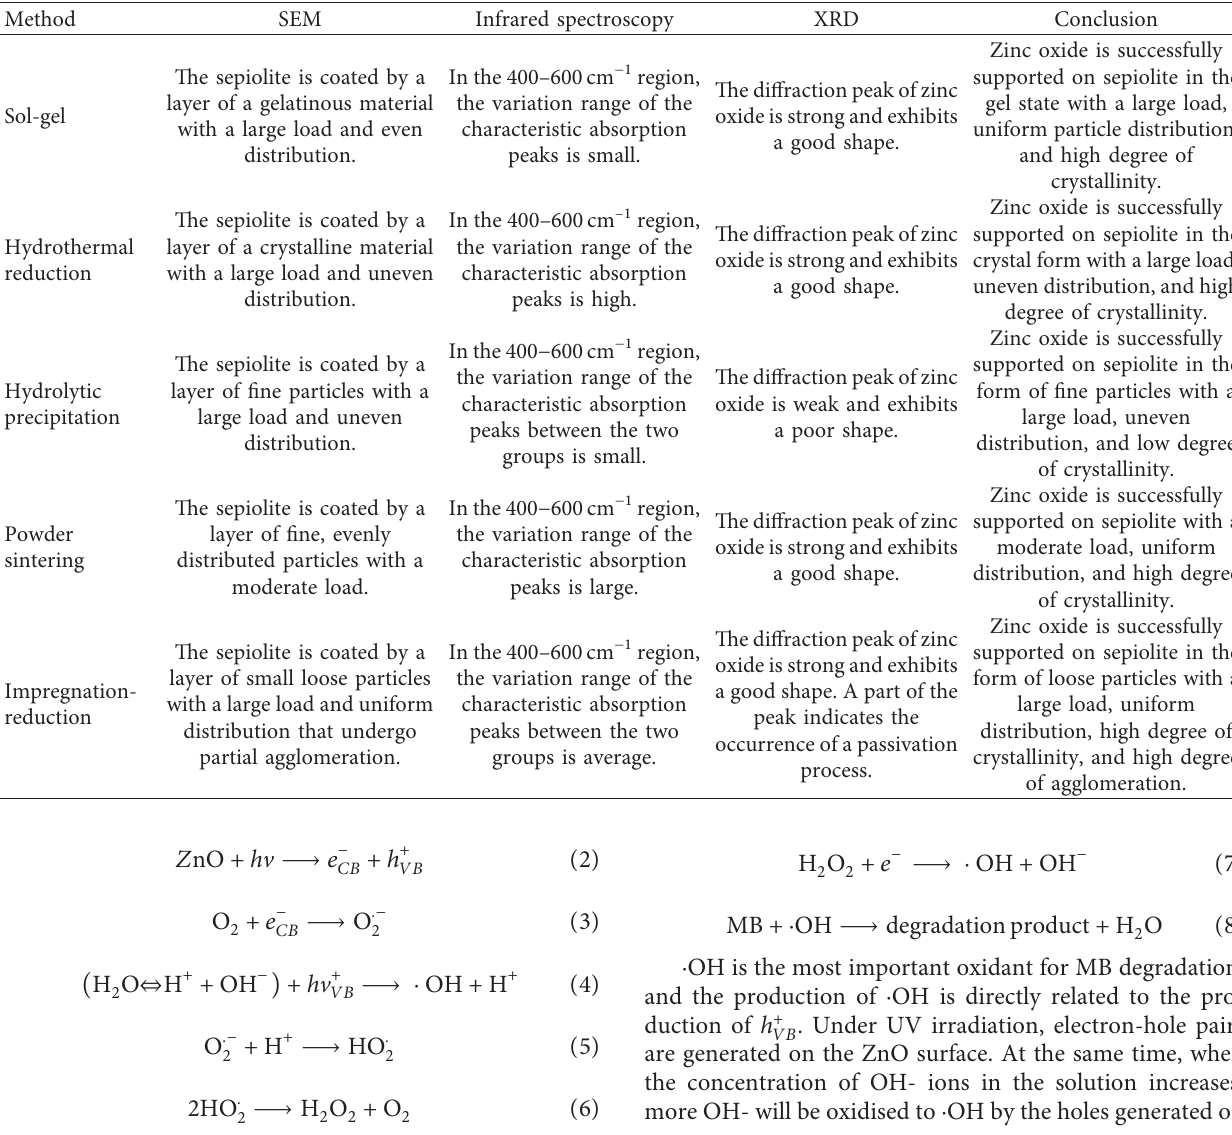
Figure 25: XRD pattern of the ZnO/sepiolite composite prepared by the impregnation-reduction method. Table 2: Characteristics of the ZnO/sepiolite composites obtained by the five different